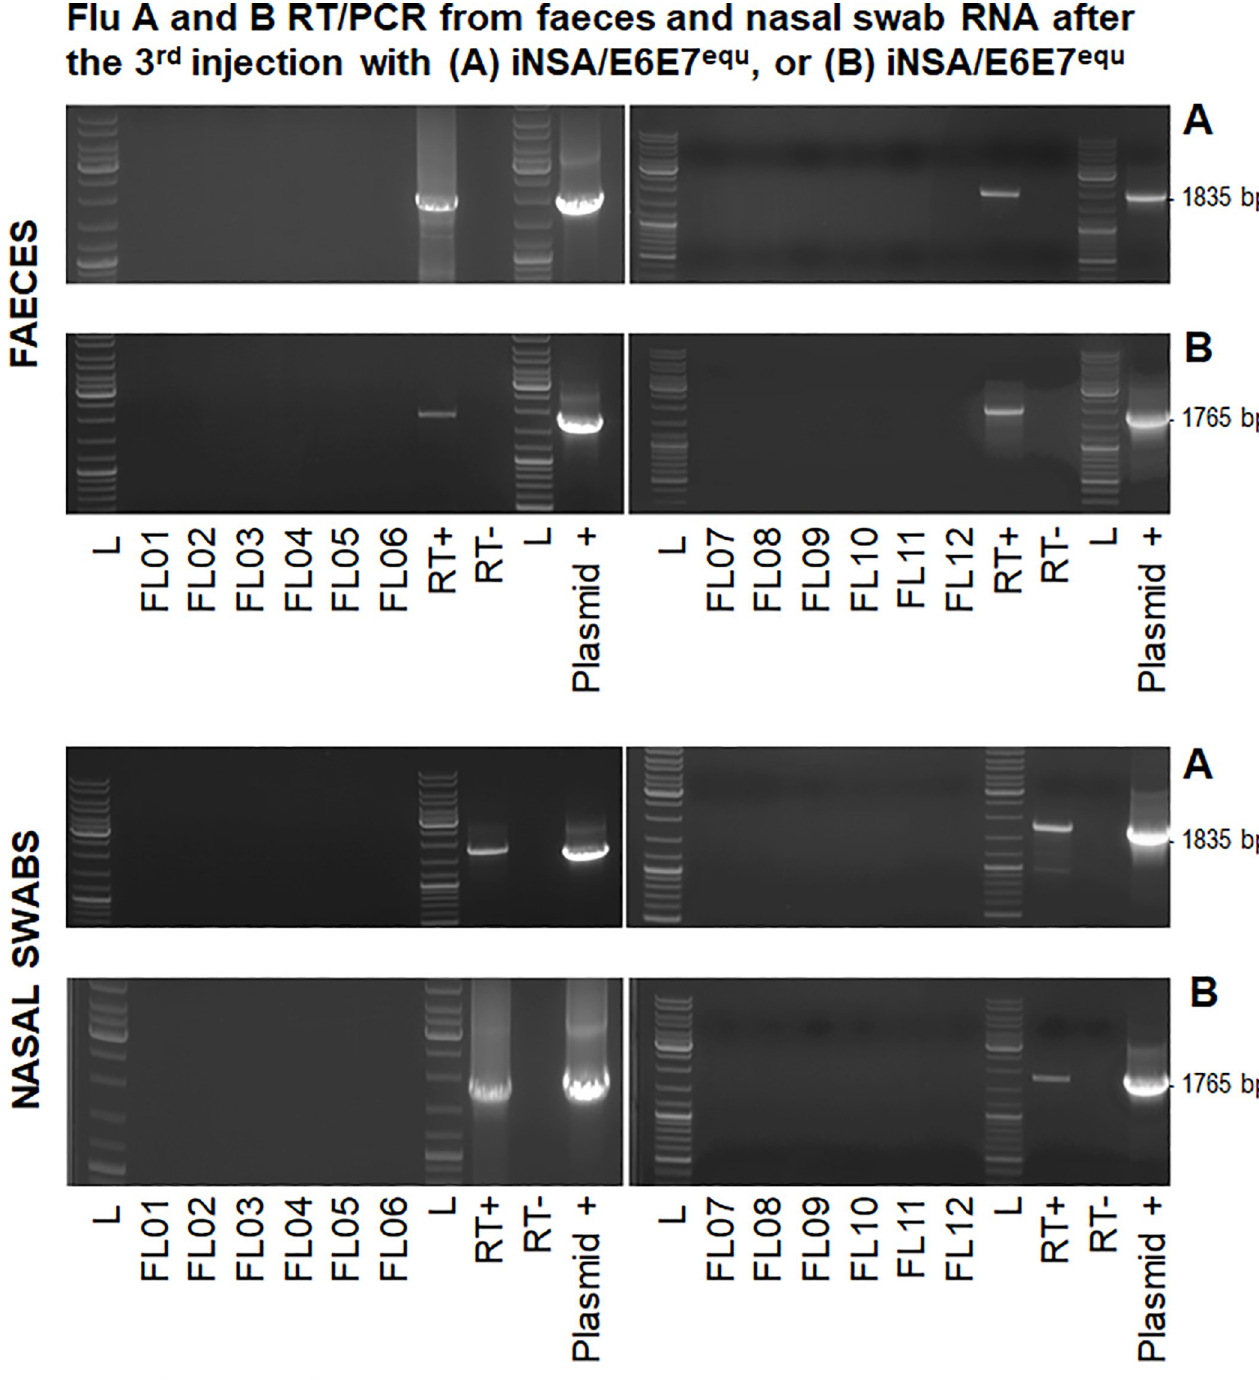
Fig 4. iNSA/E6E7 equ and iNSB/E6E7 equ were biologically safe. Top: Faeces and nasal swabs collected after each intralesional injection tested negative by RT/ PCR, whereas controls yielded anticipated results. L: GeneRuler DNA Ladder mix (ThermoScientific). Bottom: Negative RT/PCR results obtained for nasal swabs were confirmed by plaque assay thus providing additional evidence for the biological safety of iNSA/E6E7 equ and iNSB/E6E7 equ .